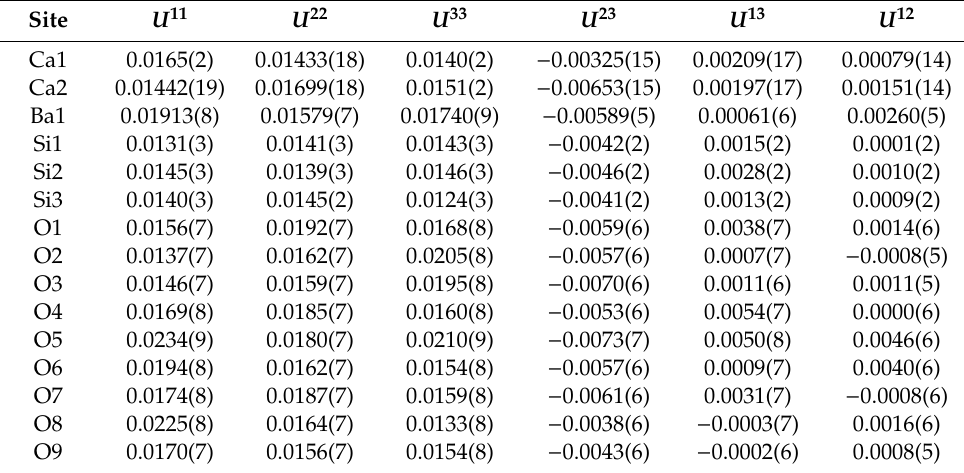
Table 3. Anisotropic displacement parameters U ij for